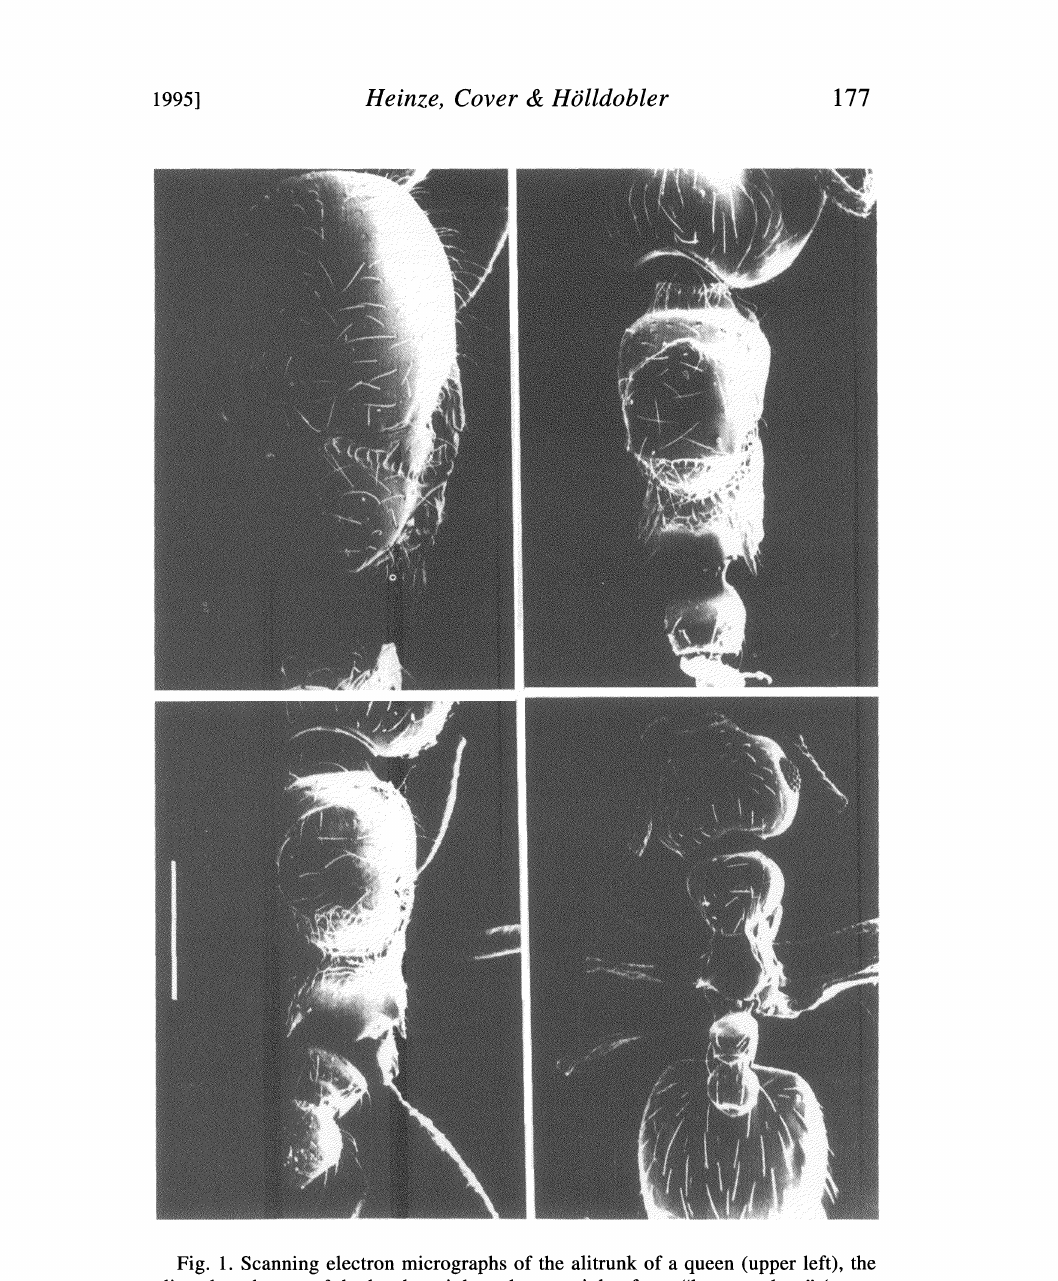
Fig. 1. Scanning electron micrographs of the alitrunk of a queen (upper left), the alitrunk and parts of the head, petiole and postpetiole of two "large workers" (upper right and lower left) and the almost complete body of a small worker (lower right) of the ant, Crematogaster smithi (all in dorsal view). The bar equals 0.5mm. The alitrunk of "large workers" shows an intermediate development of thoracic